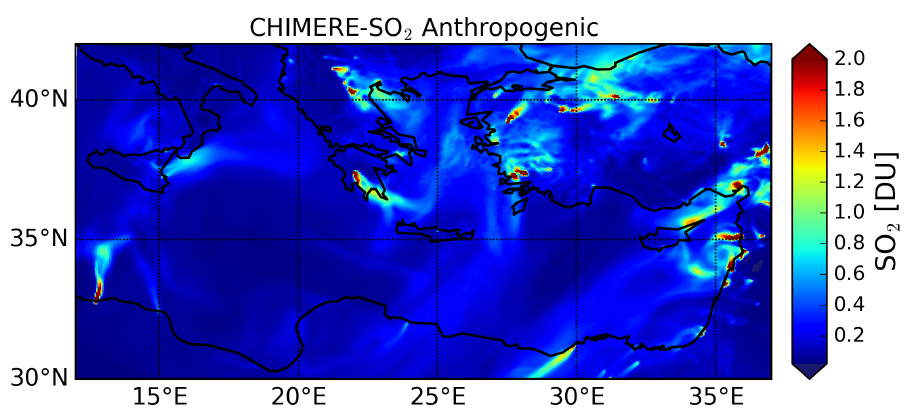
Figure 5. CHIMERE SO 2 raw column amount (anthropogenic-only run).